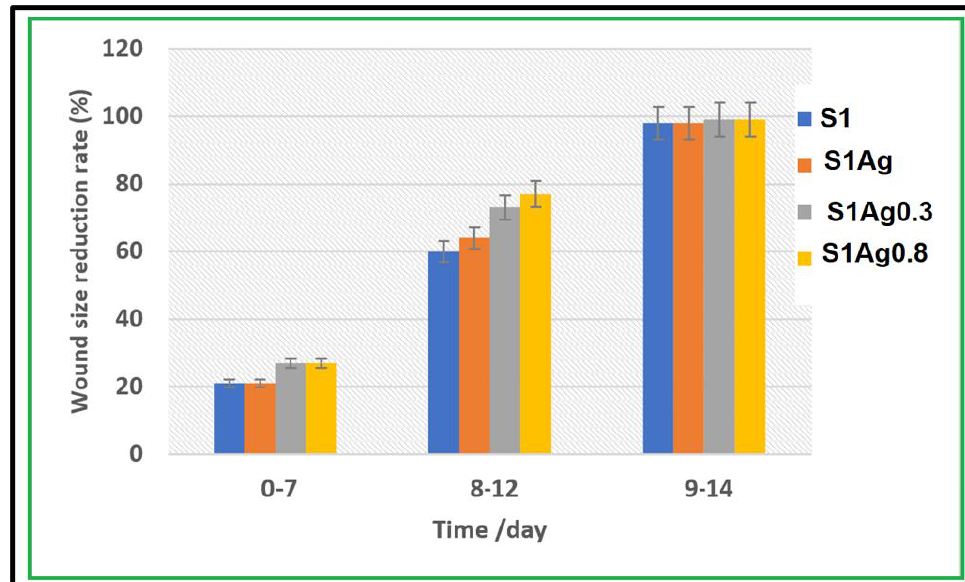
Figure 7. Skin wound size reduction after 7, 12, and 14 days.